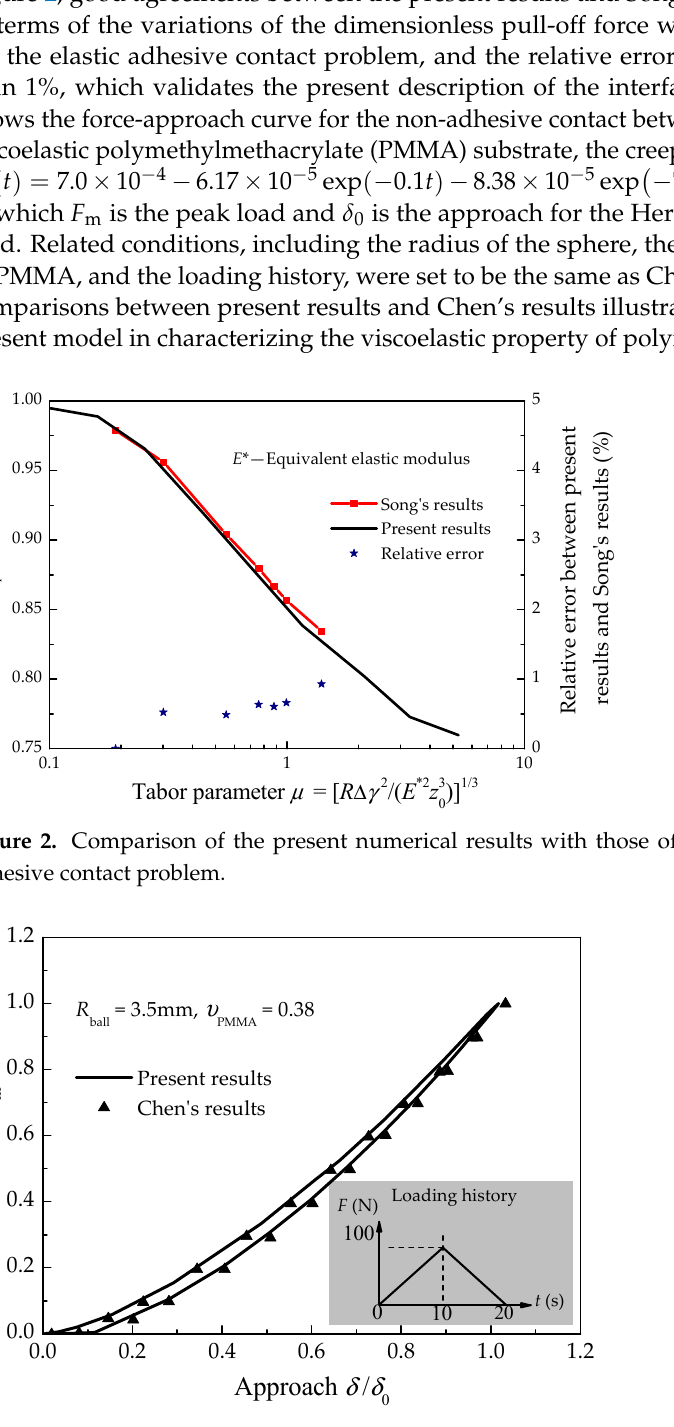
Figure 3. Comparison of the present numerical results with those of Chen’s [22] for the viscoelastic non-adhesive contact problem.